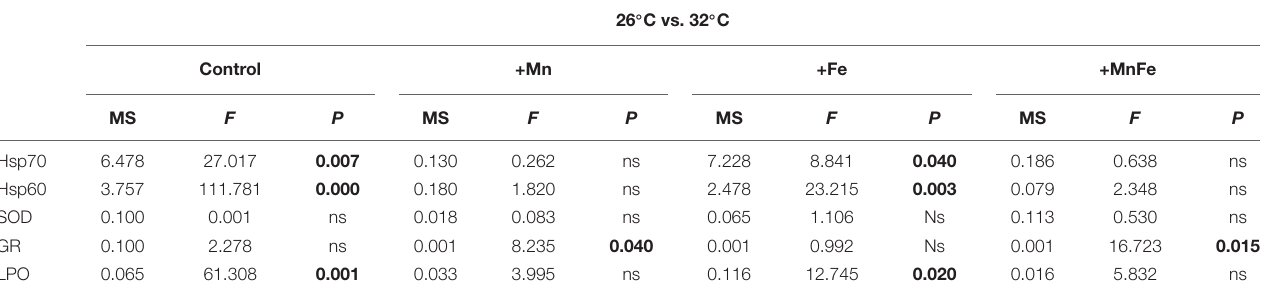
TABLE 1 | Summary of the one-way analysis of variance (ANOVA) for values of Hsp70, Hsp60, SOD, GR, and LPO in colonies maintained at 26 ◦ C vs. those subjected to thermal stress (32 ◦ C) at each metal